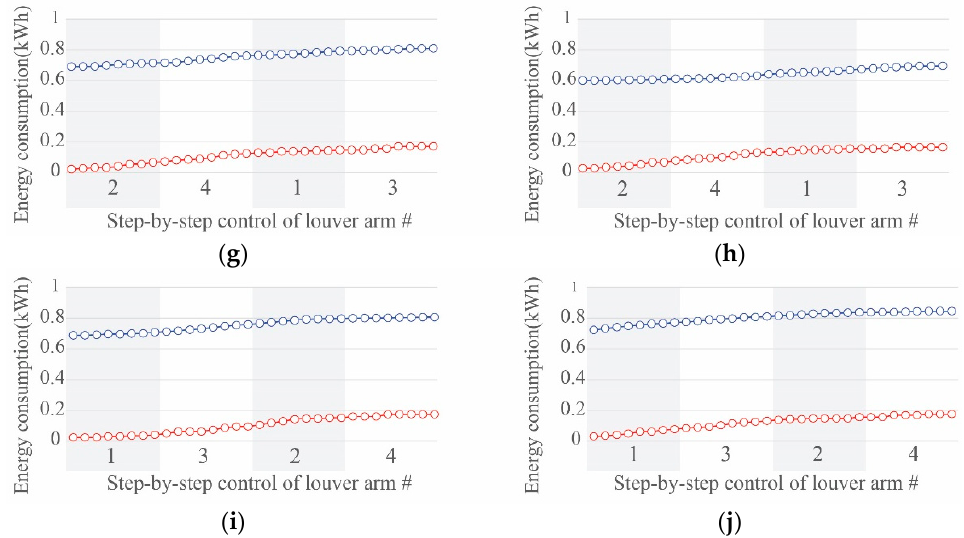
Figure 13. Analysis of lighting and cooling/heating energy consumption according to operating the proposed louver system. ( a ) From 10:00 to 11:00 in summer. ( b ) From 10:00 to 11:00 in winter. ( c ) From 11:00 to 12:00 in summer. ( d ) From 11:00 to 12:00 in winter. ( e ) From 12:00 to 13:00 in summer. ( f ) From 12:00 to 13:00 in winter. ( g ) From 13:00 to 14:00 in summer. ( h ) From 13:00 to 14:00 in winter. ( i ) From 14:00 to 15:00 in summer. ( j ) From 14:00 to 15:00 in winter. Table 7. Optimal specifications and energy consumption by time in Case 5 for saving energy consumption.